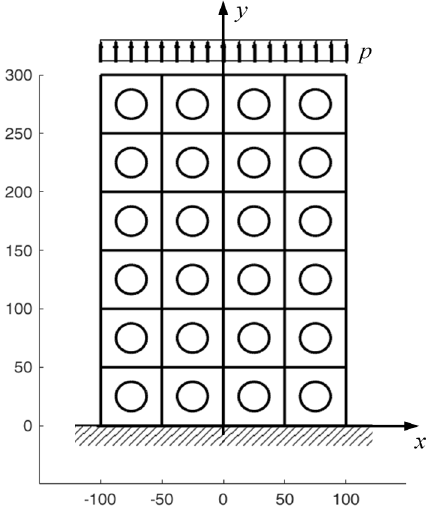
Figure32. Geometryandloadingconditionofthe6 × 4arraywithroundinclusions(linearmeasurements Figure 32. Geometry and loading condition of the 6 × 4 array with round inclusions (linear in measurements in mm).